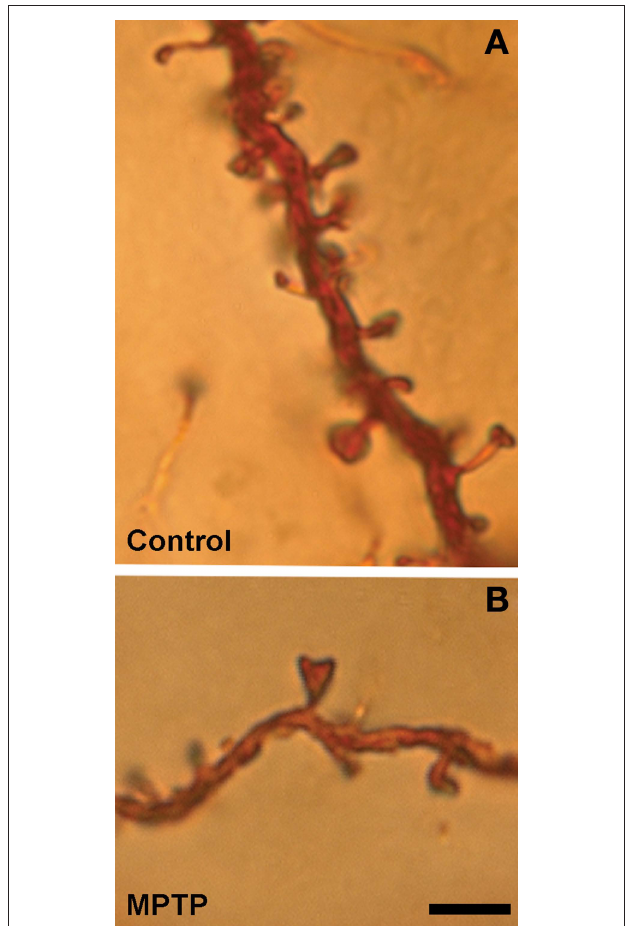
Figure 2 | Dendrites from golgi-impregnated MSNs in the caudate nucleus of a control (A) and a MPTP-treated (B) monkey. Note the dramatic spine loss on the dendrite of the MSNs from the MPTP-treated monkey compared with control. Scale bar in (B) [valid for (A) ]: 5